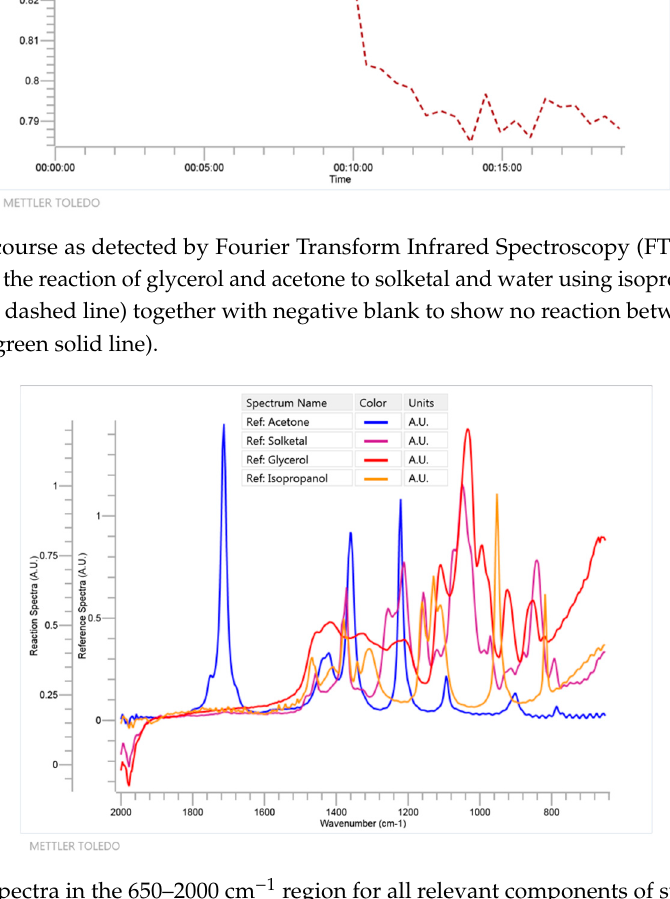
Figure 4. FTIR spectra in the 650–2000 cm − 1 region for all relevant components of system 1 with the exception of water and isopropanol, which was added as a solvent to create and maintain a monophasic system during the ketalization process.